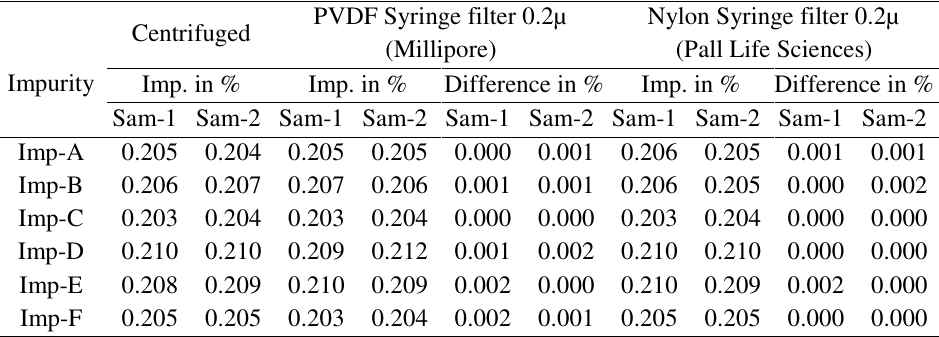
Table 12. Filter compatibility